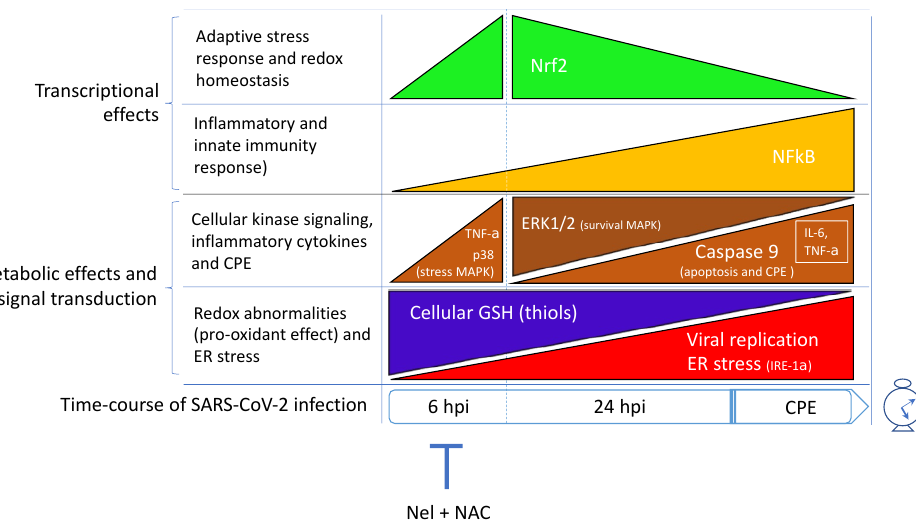
Figure 4. Signal transduction, transcriptional and metabolic effects of SARS-CoV-2 infection in Vero E6 cells. The time-course of the main effects shown in the chart include the modulation of stress response and apoptotic pathways, inflammatory genes and innate immunity of the host cell that were identified according to [8,13]. The reported time-points were 6 h post infection (hpi) and 24 hpi; these indicate the earliest and late phase of the viral replication process in which the cytopathic effect (CPE) of the virus develops, respectively. Nelfinavir (Nel) and N-acetyl cysteine (NAC) reverse the reprogramming effect of SARS-CoV-2 infection on the transcriptional and metabolic parameters of the host cell, acting early during the viral replication process to prevent ER reprogramming and Cys consumption for viral protein synthesis (shown in Figures 1 and 2).